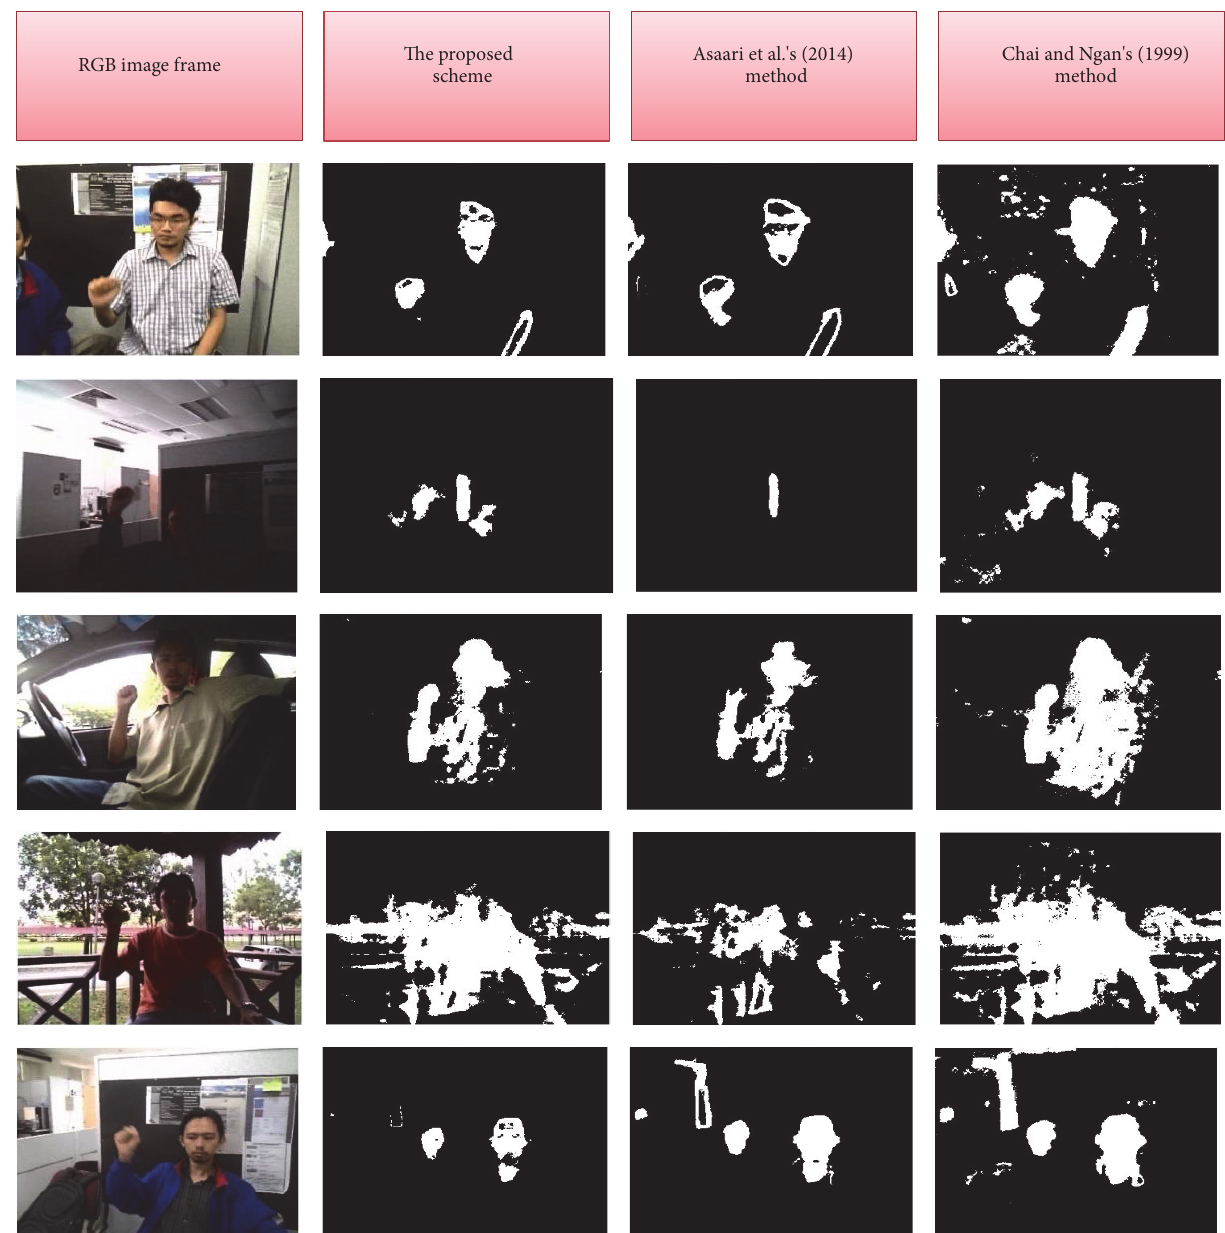
Figure 10: Comparison between different skin colour segmentation methods based on pretrained thresholds in Cb-Cr